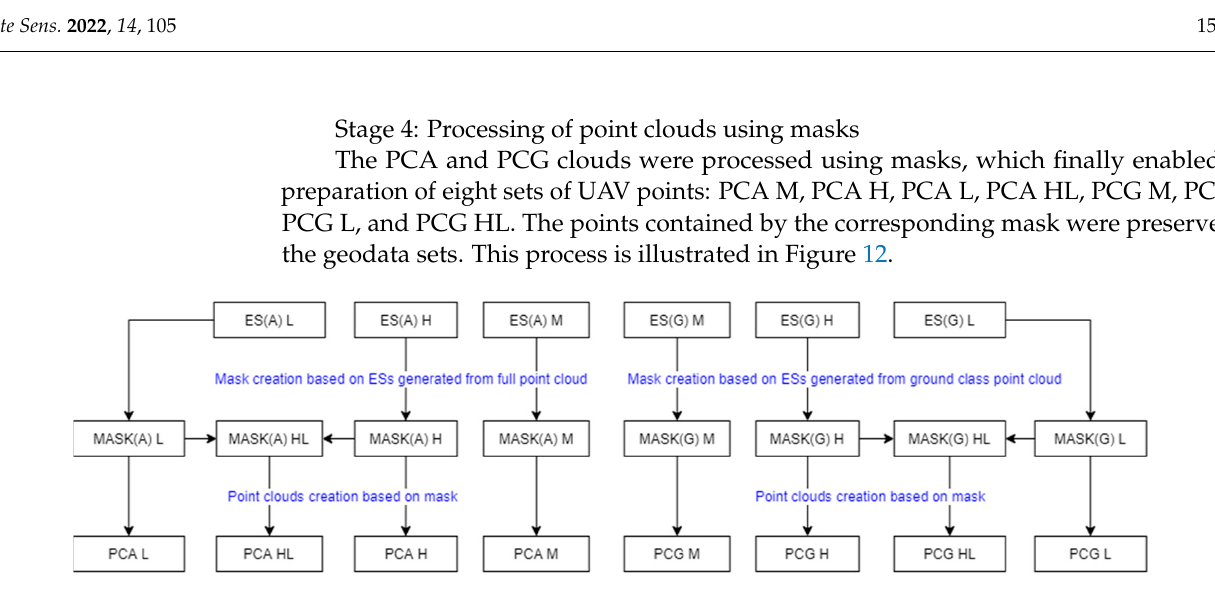
Figure 12. Scheme for creating masks from ES(A) and ES(G) surfaces and processing point clouds using them.